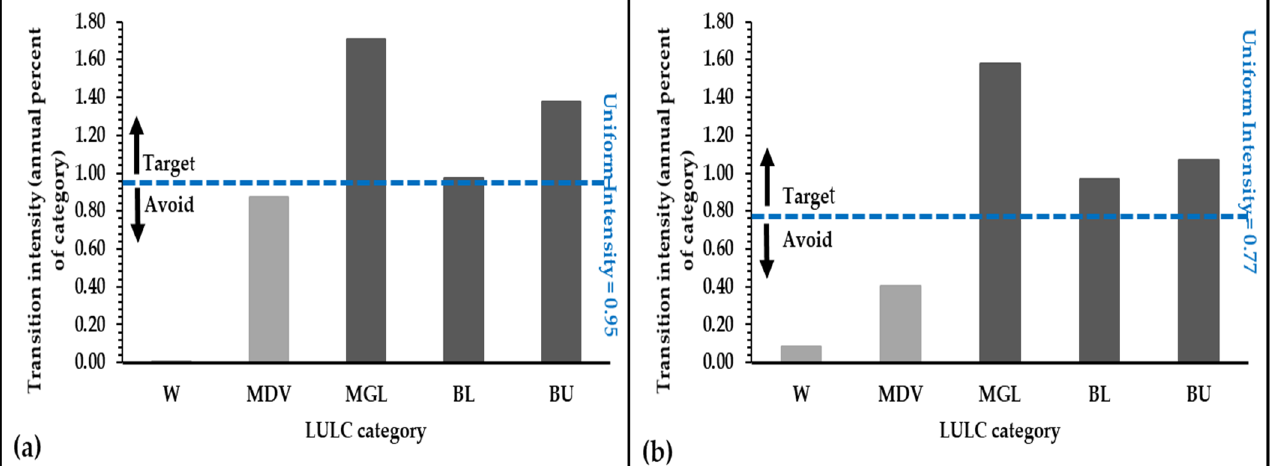
Figure 5. Transition to cultivated land for ( a ) 1991–2007 and ( b ) 2007–2020 for the KLCRS.